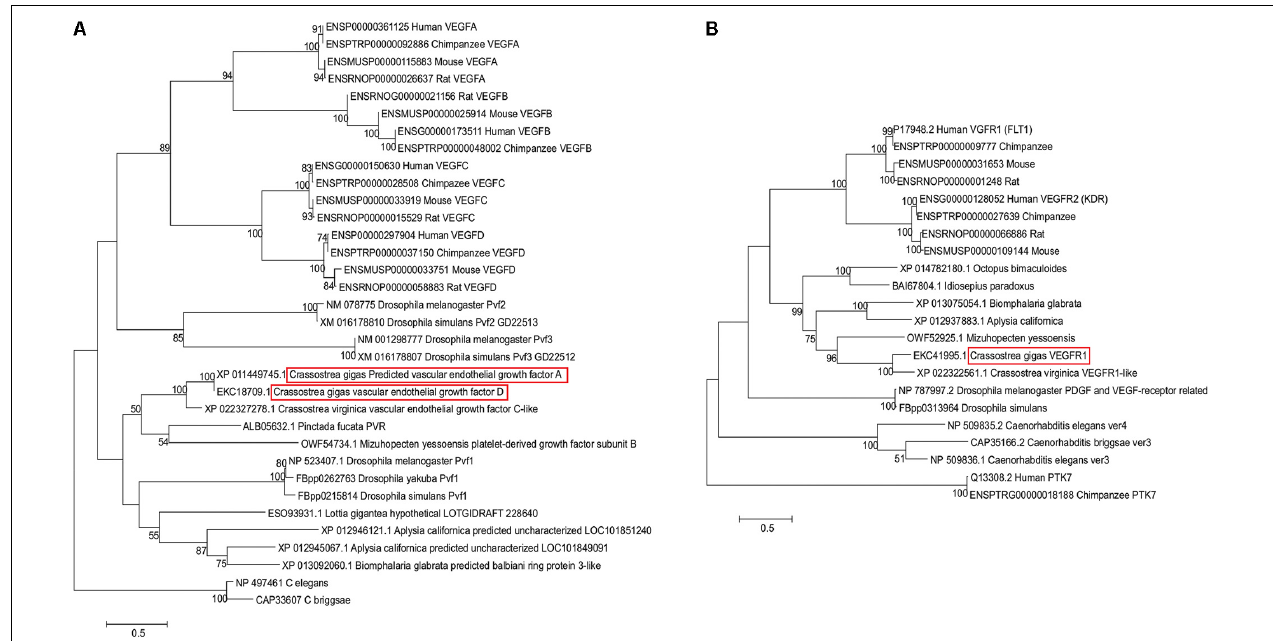
FIGURE 1 | Maximum-likelihood-based phylogenetic trees of VEGF (A) and VEGFR (B) sequences reconstructed using JTT+gamma substitution model. Each sequence is designated by its GenBank or Ensembl accession number and species name. Sequences from C. gigas are highlighted with red boxes. Numbers above branches represent percent bootstrap